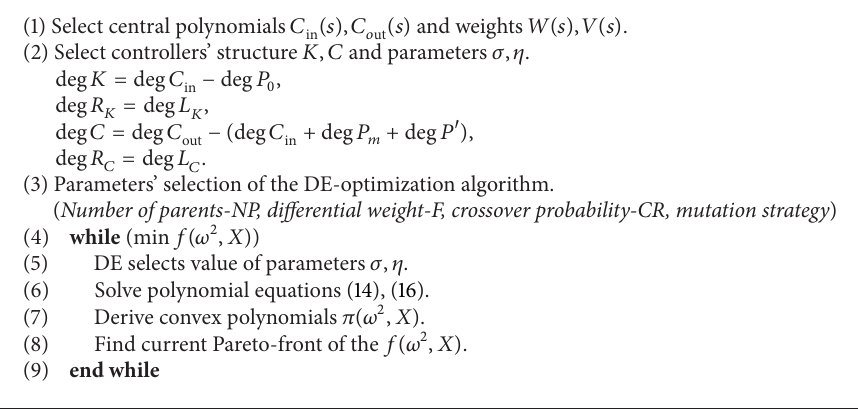
Algorithm 1: Multiobjective DE algorithm.